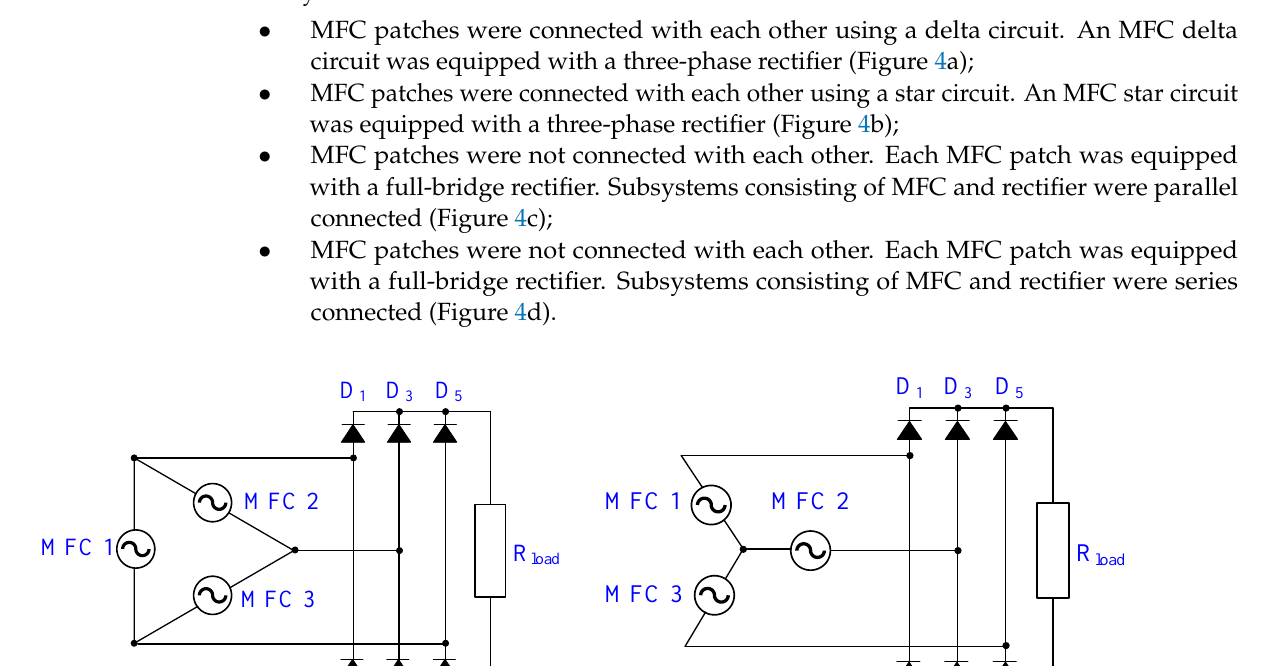
Table 3. Conditions of laboratory experiments.